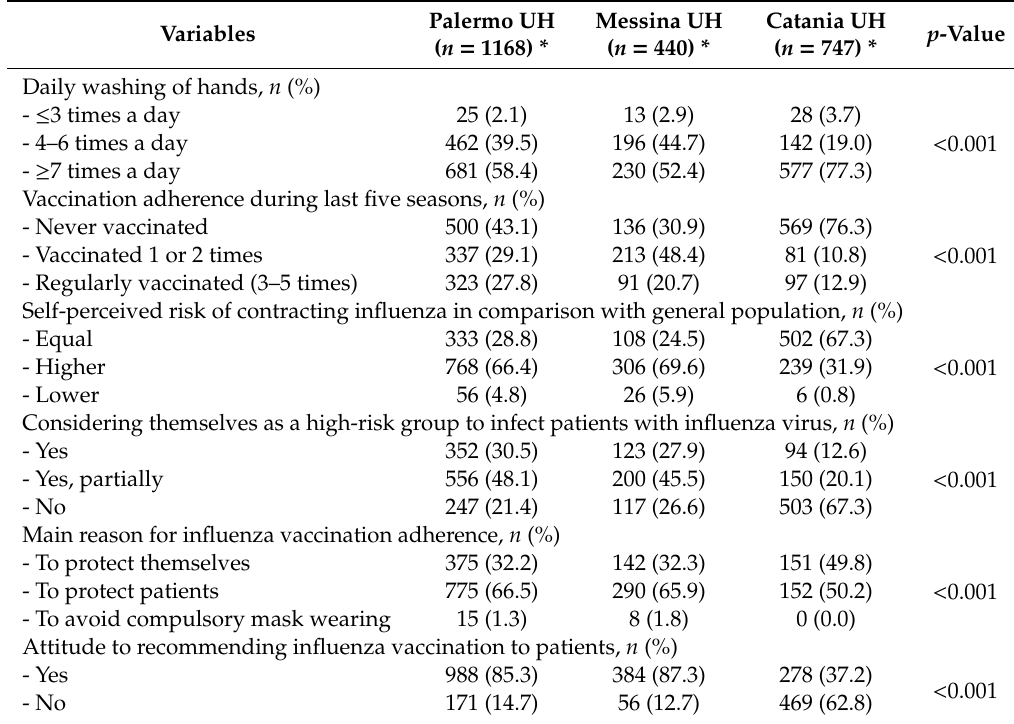
Table 2. Univariate analysis of the preventive attitudes of HCWs vaccinated against influenza at the three Sicilian University Hospitals ( n =